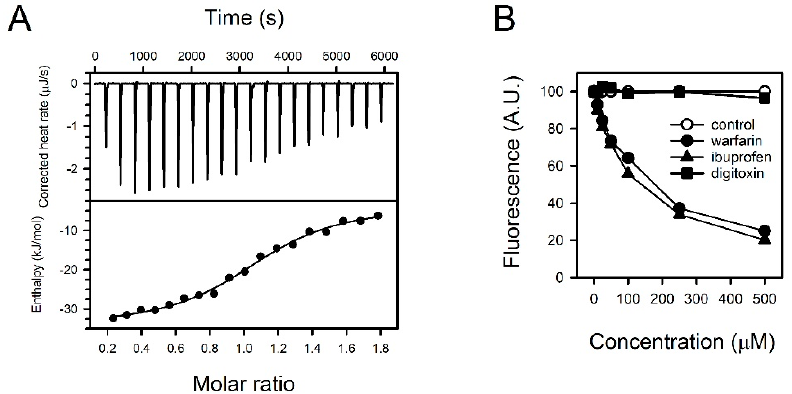
Figure 4. Binding properties of fisetin and HSA. ( A ) The titration curve was prepared with fisetin and HSA employing isothermal titration calorimetry (ITC). The heat rate upon binding was measured (upper panel), and the enthalpy was fitted versus the molar ratio with an independent binding model (lower panel). ( B ) The fisetin in fisetin–HSA complex was displaced by supplementing the binding site-specific drugs warfarin, ibuprofen, or digitoxin. The fluorescence from fisetin–HSA complex without drugs was regarded as 100%, and the relative intensities of fluorescence were presented.